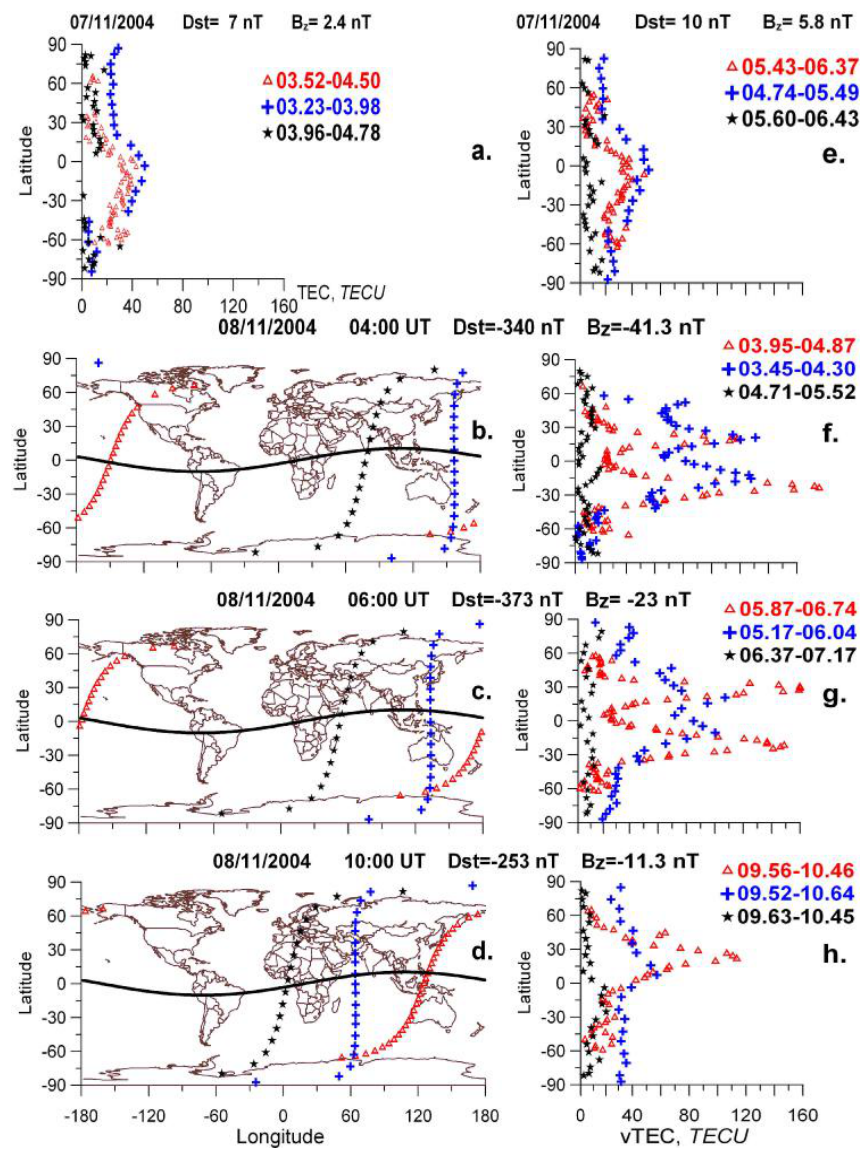
Fig. 3. The same as in Fig. 2 but for quiet day 7 November 2004 (a) , (b) and geomagnetic storm on 8 November 2004 (e–h) and Jason-1 measurements (red triangles). The time when the satellites cross the equator is: Jason-1 ∼ 18:30LT, CHAMP ∼ 14:30LT, SAC-C ∼